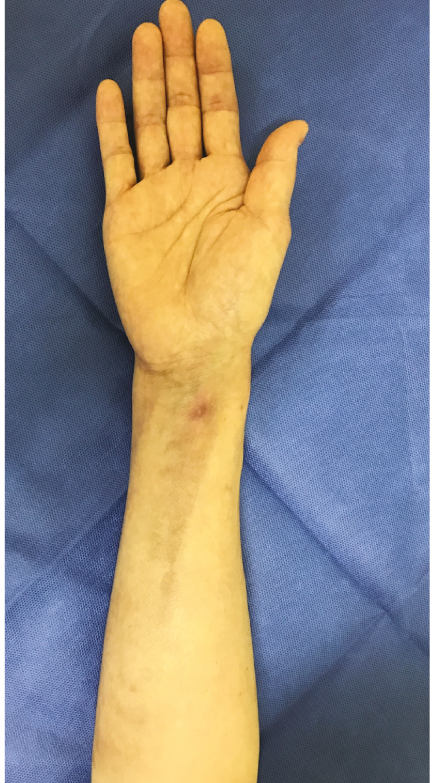
Figure 4: Forearm skin state 6 months after the operation. The forearm skin state and surgical wound favorably improved, and she returned to her preinjury job without any problems in daily